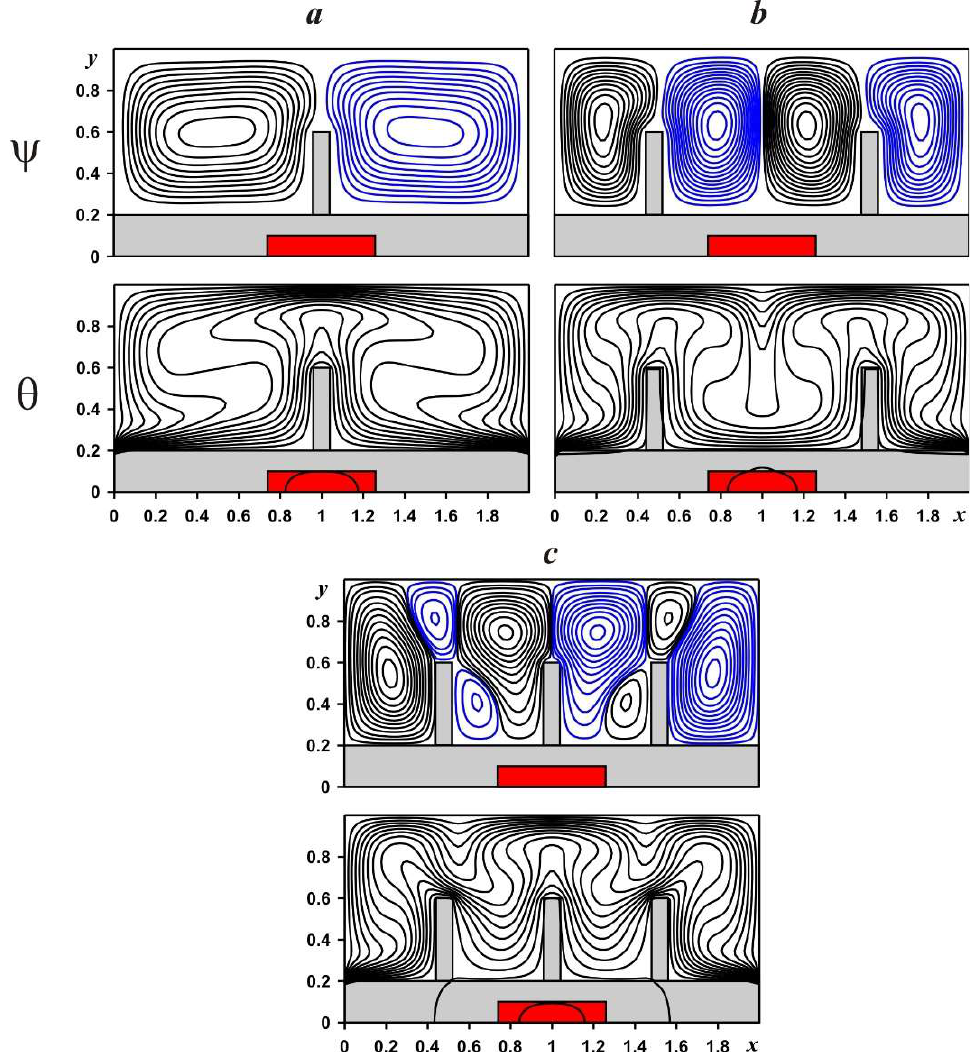
Figure 5. Streamlines and isotherms in a cavity with solid fins: one fin—( a ), two fins—( b ), three fins—( c ).